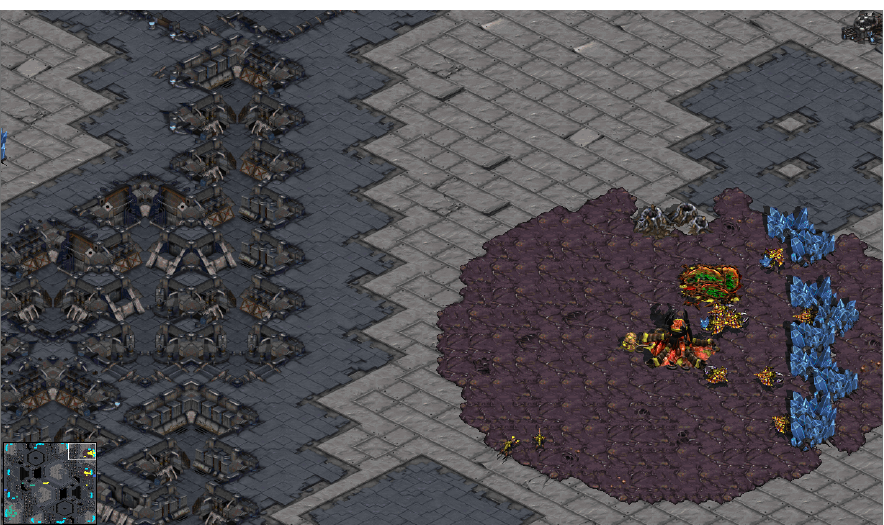
Figure 1. A screenshot of